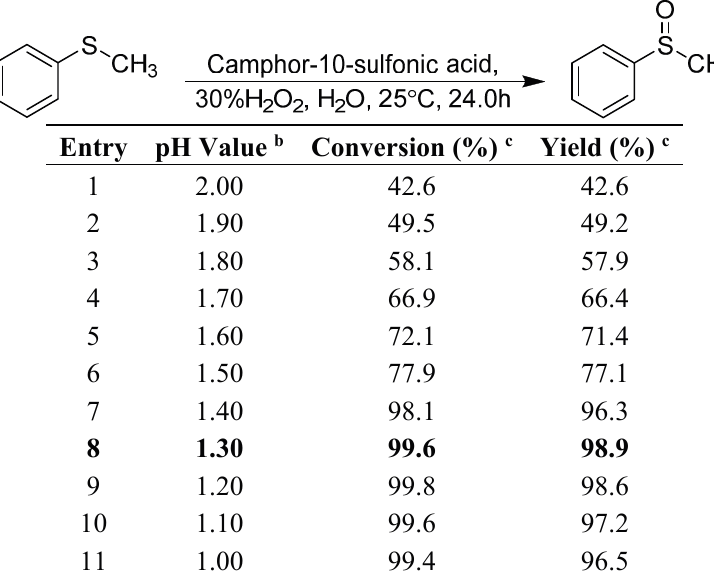
Table 3. Effect of pH value on the oxidation of methyl phenyl sulfide with H 2 O 2 catalyzed by camphor-10-sulfonic acid a